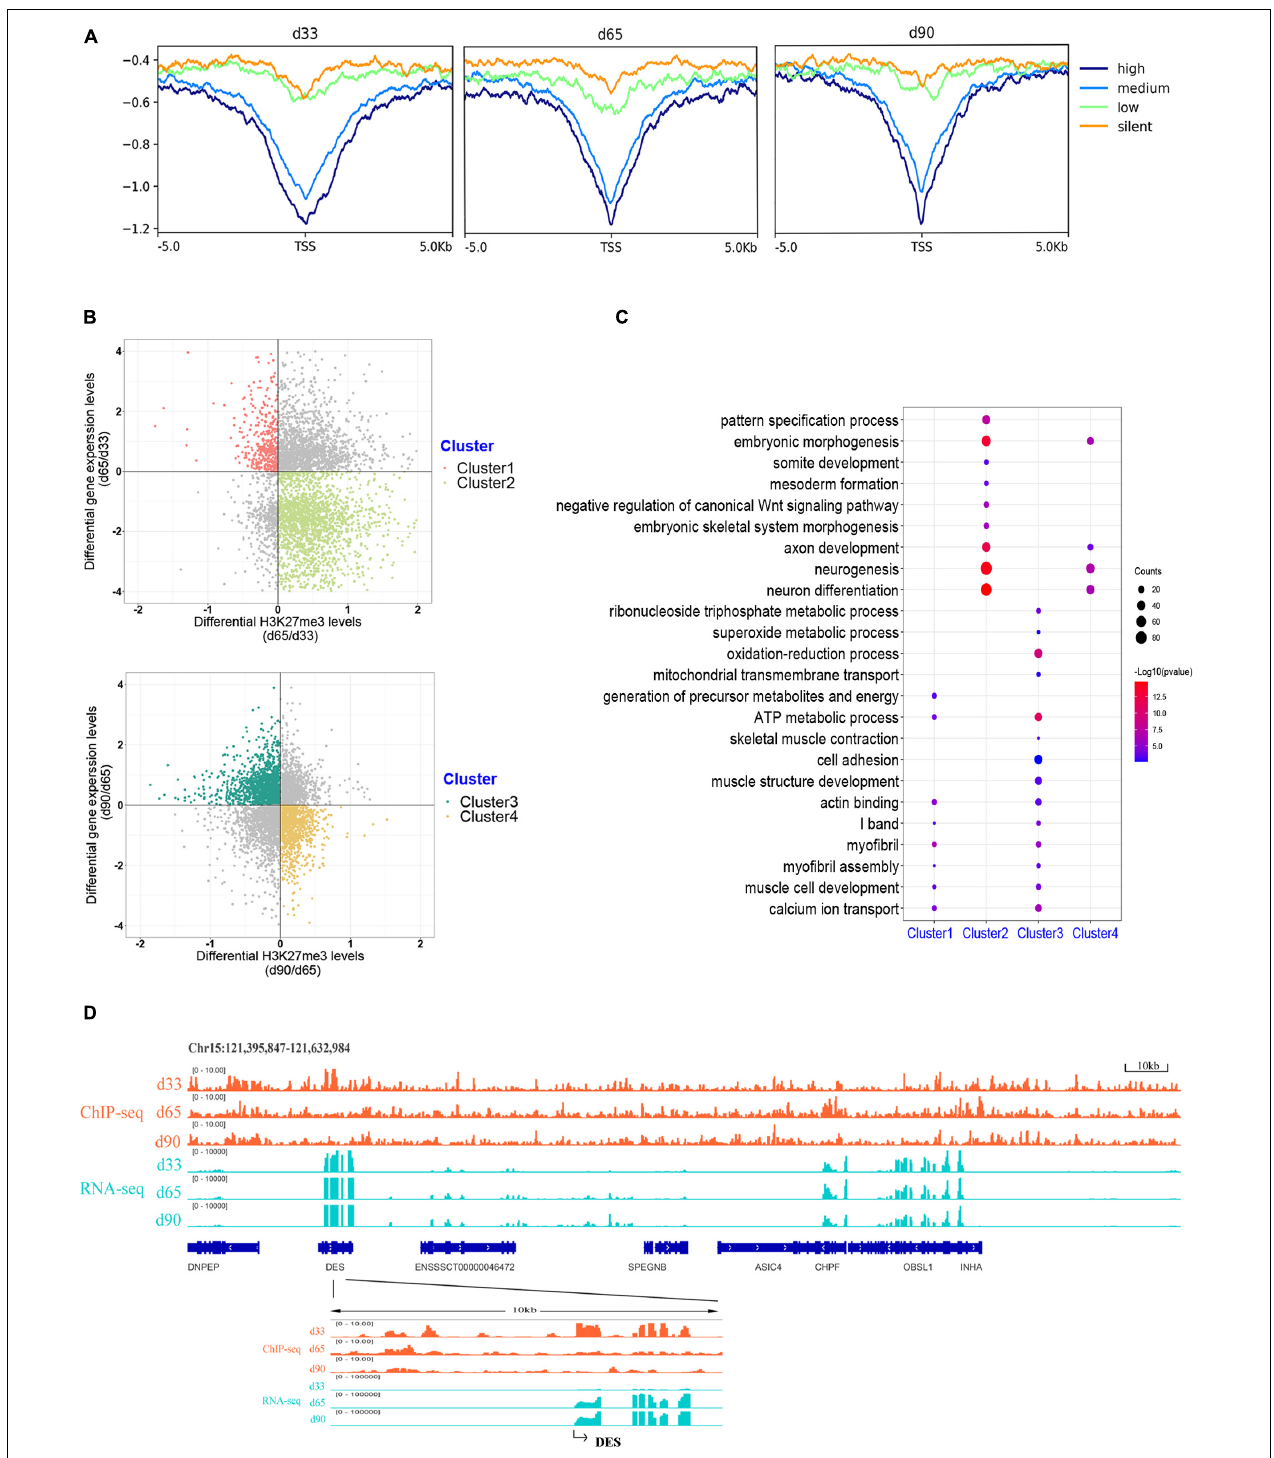
FIGURE 4 | Association analysis between H3K27me3 and gene expression level. (A) The enrichment profile of H3K27me3 in all expressed gene. The y -axis was the average log2 fold change compared with control. High (TPM ≥ upper quartile; medium (lower quartile < TPM < upper quartile); low (TPM ≤ lower quartile); silent (never express). (B) Distribution of different expressed genes comparing the H3K27me3 levels and mRNA level. (C) The GO enrichment analysis of the DEGs exhibiting negative correlation between H3K27me3 and mRNA levels. (D) Genome browser tracks showing H3K27me3 ChIP-seq (orange) and RNA-seq (light blue) data at DES loci during embryonic muscle development. Promoter region (TSS ± 5 kb) of DES was zoomed in.